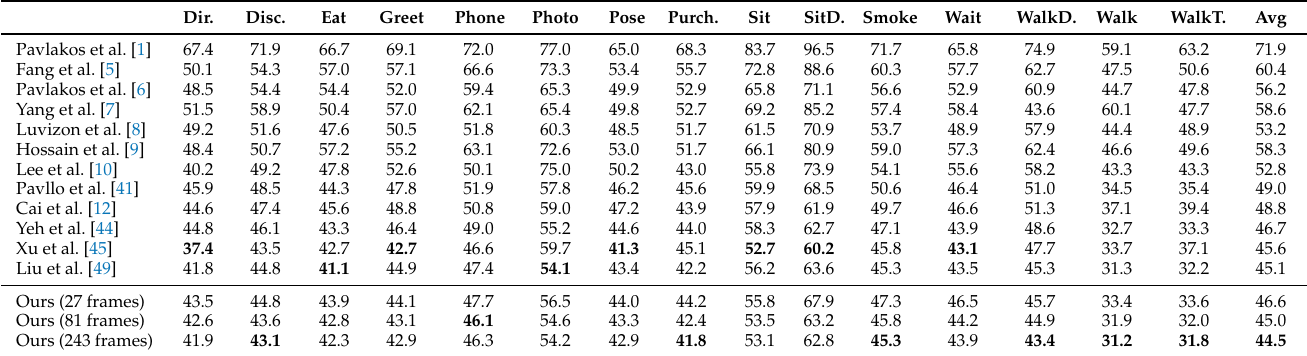
Table 1. Reconstruction error on Human3.6M under protocol 1. Results are in millimeters.